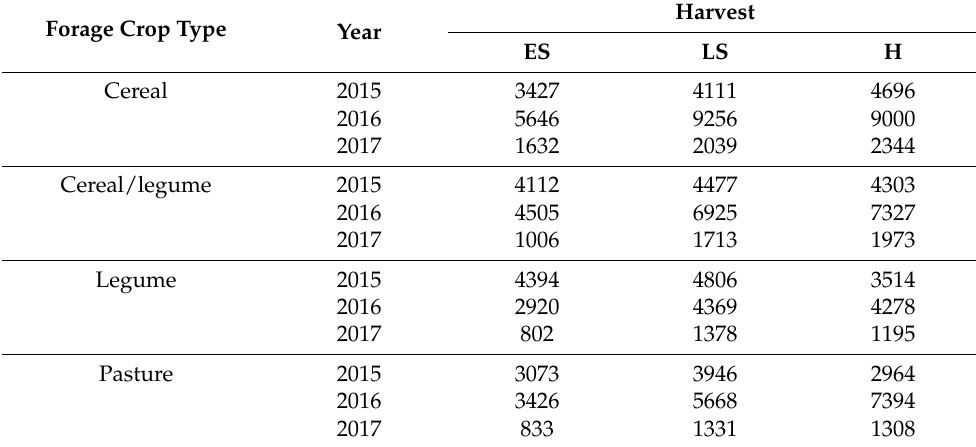
Table 4. Yield (kg DM/ha) of forage crops grown in 2015–2017 at Wagga Wagga, NSW, and forage harvested as early silage (ES), late silage (LS) or hay (H). Forage Crop